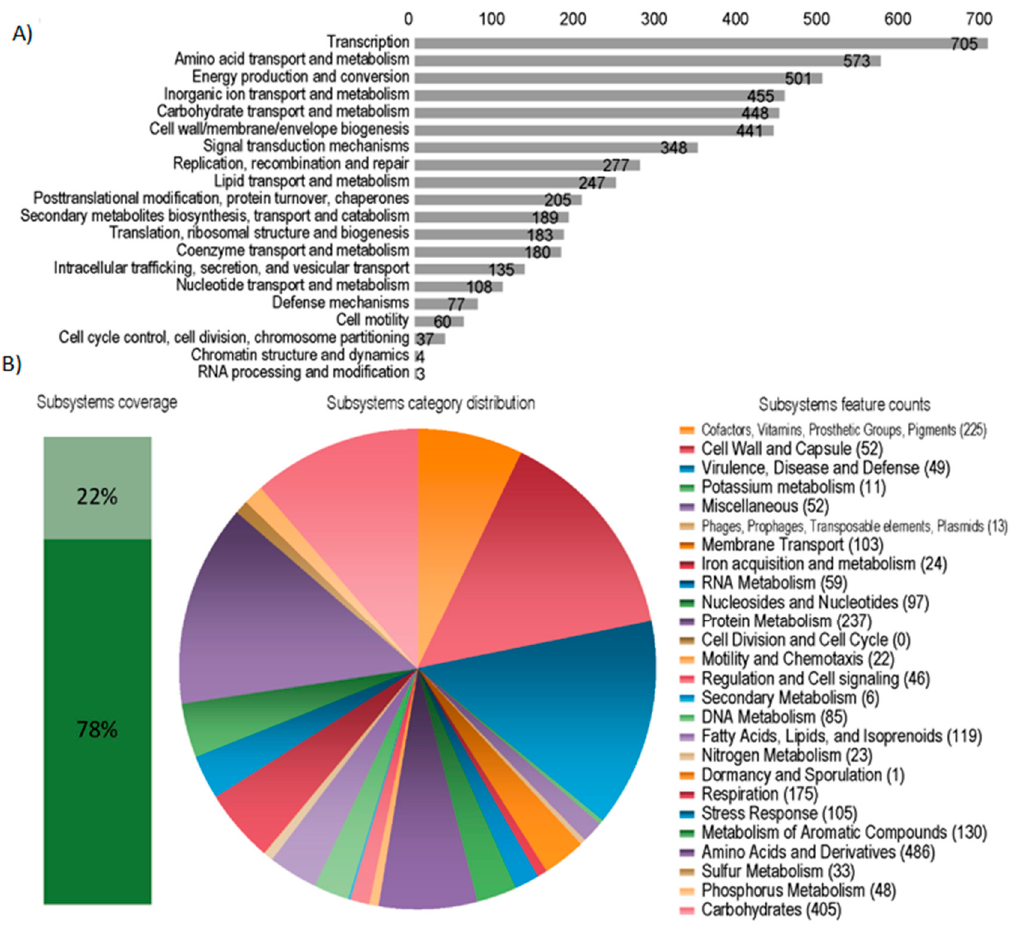
Figure 1. Statistics of the Clusters of Orthologous Groups of proteins (COGs) and Rapid Annotation using Subsystem Technology (RAST) of Paraburkholderia tropica strain IAC / BECa 135. ( A ) COG category distribution showing the number of genes annotated in each category. ( B ) Subsystem category distribution. The light green bar represents the percentage of proteins that could be annotated by the RAST server and the dark green bar represents the proteins that were not annotated. The pie chart represents the number of proteins annotated to each subsystem category.